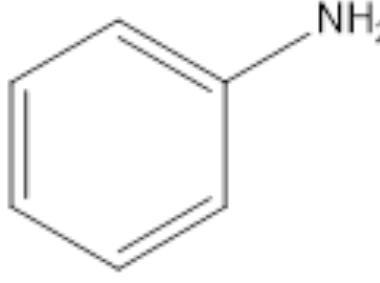
Figure 1. Aniline monomer.